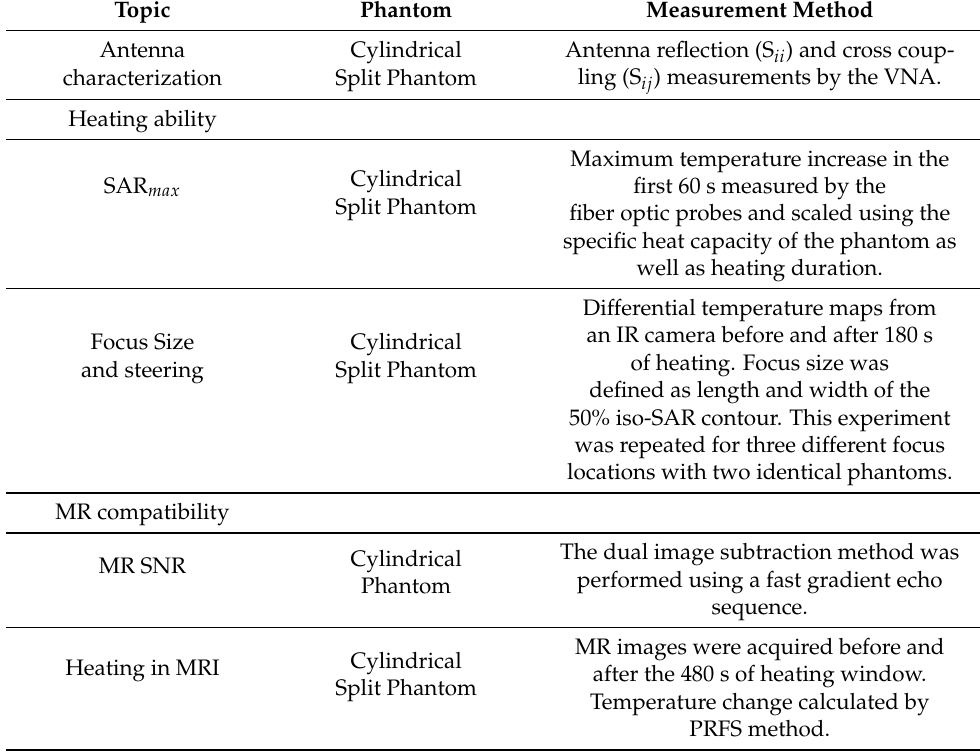
Table 1. Summary of the